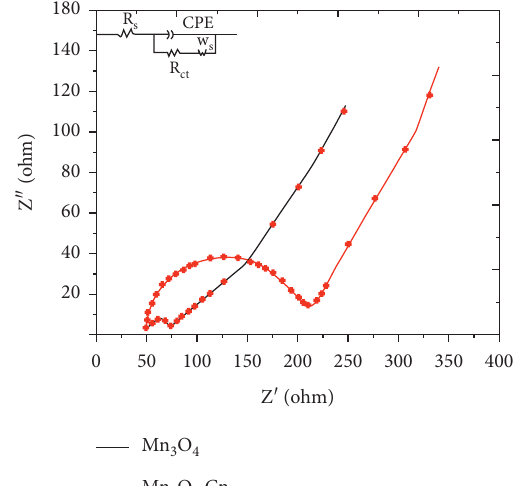
3 O 4 and (b) Mn 3 O 4 -Cn.